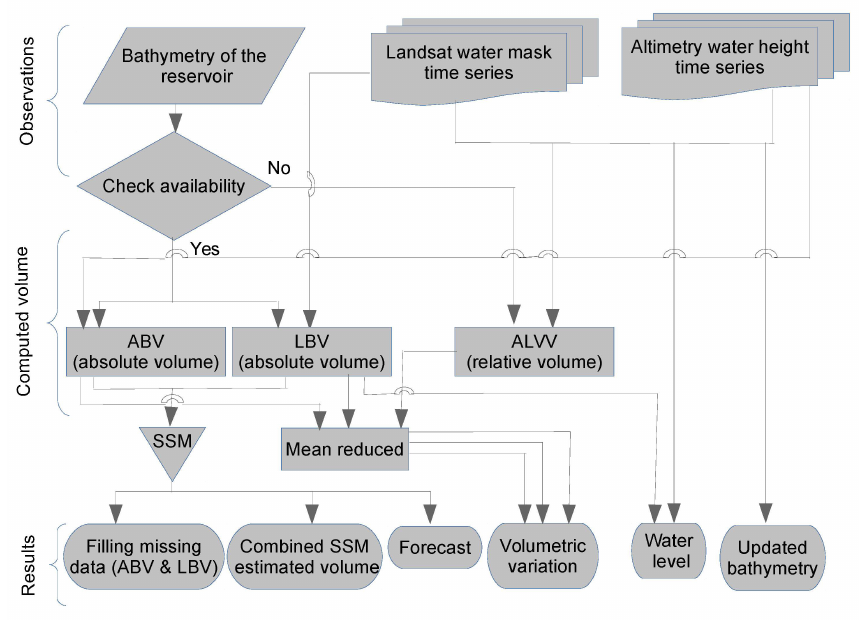
Figure 1. Methodology of the